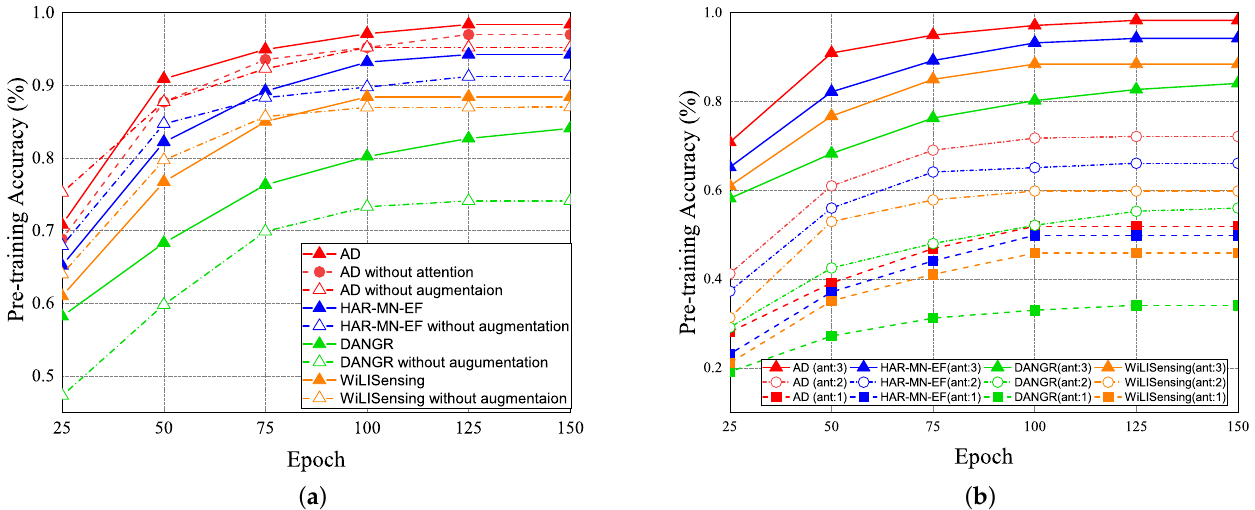
Figure 18. PTA vs. epoch for ( a ) data argumentation in different methods. ( b ) different number of antennas in different